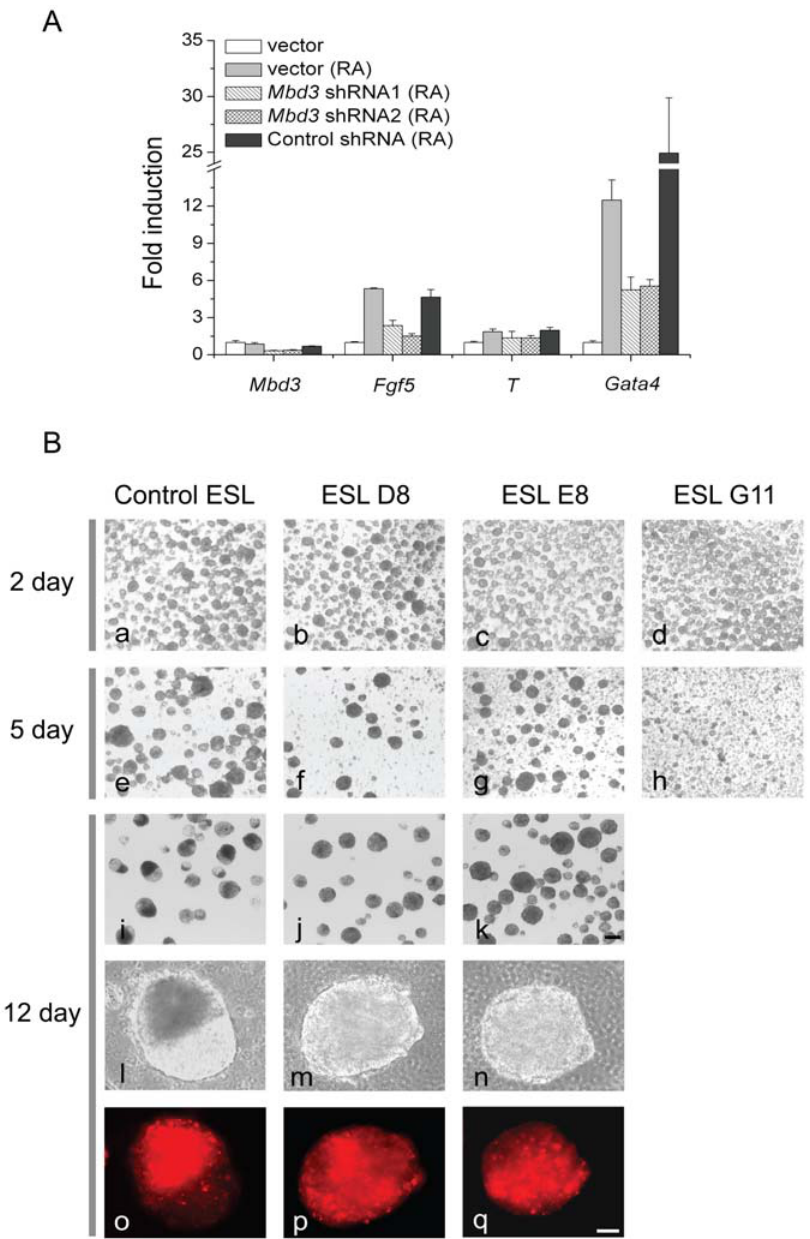
Figure 5. Full differentiation potential of mouse of ES cells is compromised when Mbd3 expression is reduced. A) ES cells cultured with or without retinoic acid for three days were subjected to real-time RT-PCR analysis. For differentiations, 1 m M retinoic acid (RA) was used or LIF was withdrawn from the medium. ES cells were transfected with respective plasmids for three days before RA addition and selected with antibiotics for five days. Error bars represent standard deviation from three technical repeats. B) Embryoid body (EB) formation of control or Mbd3 knockdown stable cells. Stable cells (2 6 105) were suspension cultured in ES cell medium without LIF in 35 mm cell dishes. Scale bars: k, 200 m m (also applies to a to j); q, 50 m m (also applies to l to